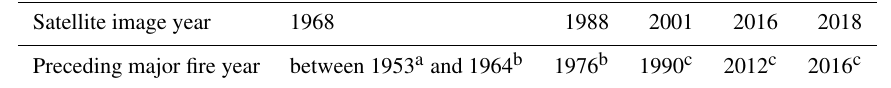
Table 4. Relations between Landsat mosaic years and the years of major